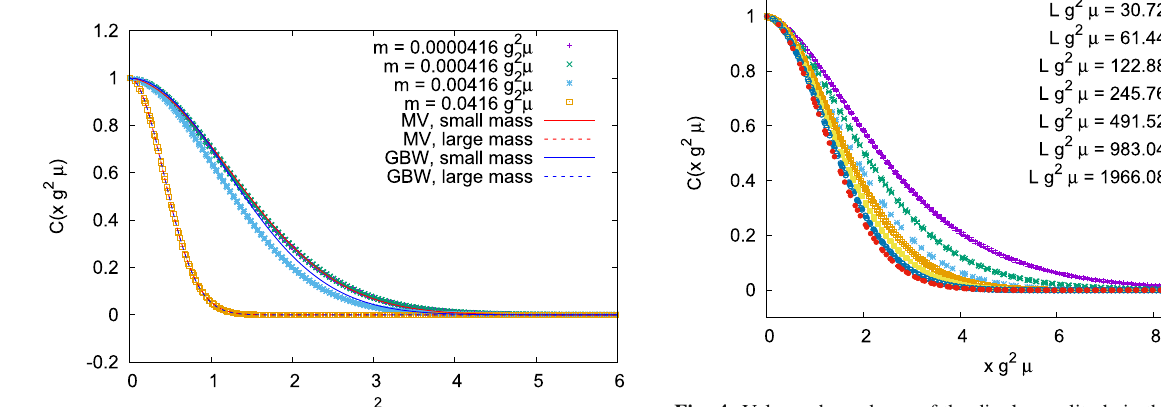
Fig. 4 Volume dependence of the dipole amplitude in the MV model on the torus. Increasing torus size pushes the distribution to the left. Consecutive volumes differ by a factor 4 (factor 2 in linear extend). Convergence to some limiting distribution can be seen for very large